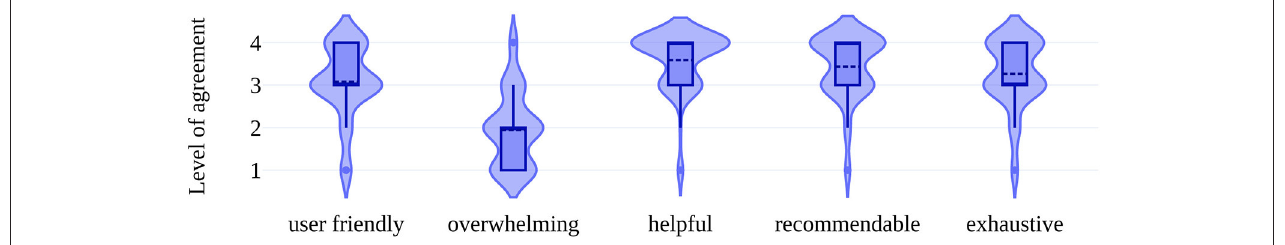
FIGURE 3 | Participants’ perception of the website. Violin plots show the distribution of answers (for violin plot detail see Figure 2 ). This figure shows the level of agreement on a 4-point Likert-scale ranging from 1 = low agreement to 4 = high agreement to the categories seen on the x -axis. Note the 4-point format to push participants to take positions and avoid neutral